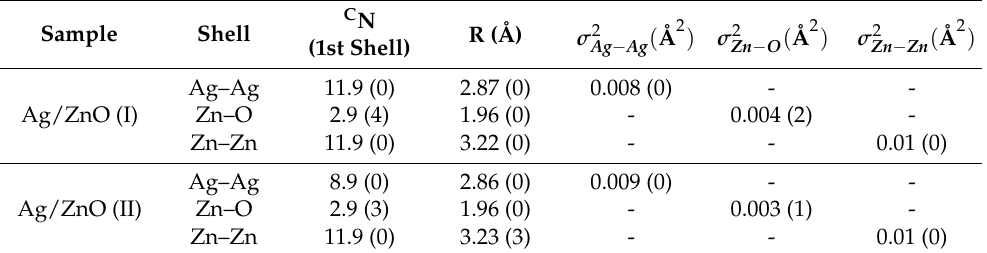
Table 2. The obtained values of the first shell, coordination number (CN), bond length(R) and Debye– Waller σ 2 factor for nearest neighbor (Ag–Ag), (Zn–O), and (Zn–Zn) scattering from EXAFS fitting. The number in the parenthesis indicates the uncertainty in the last digit.